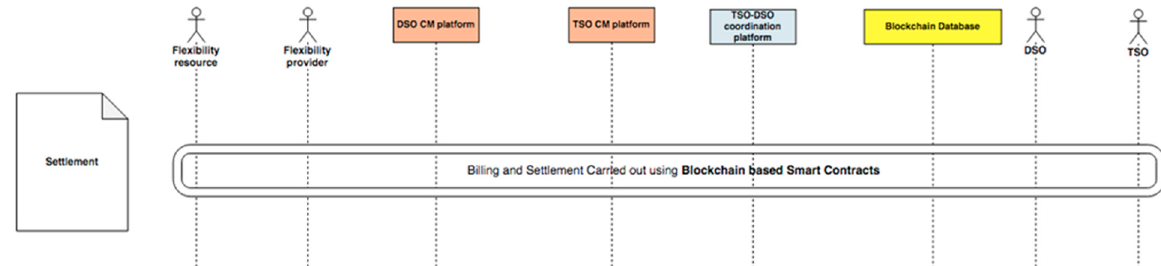
Figure 16. Settlement.